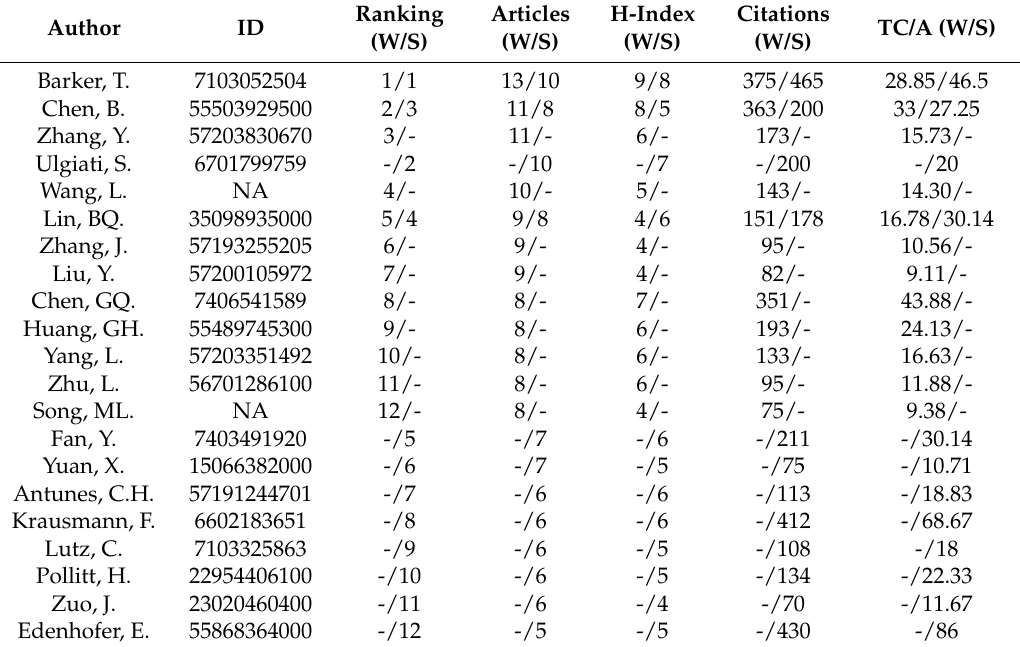
Table 5. Distribution of articles by author (Web of Science